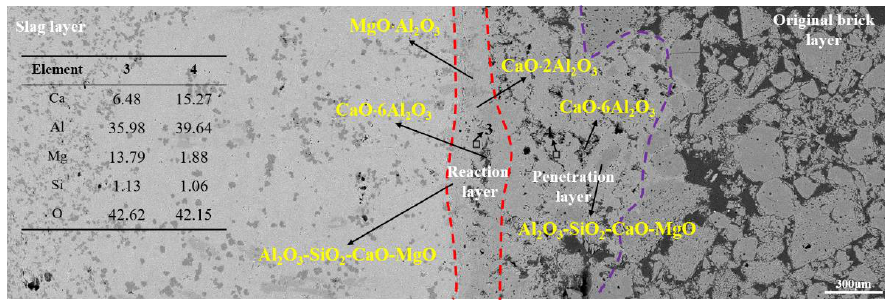
Figure 5. The SEM image of the Al 2 O 3 crucible after corrosion by